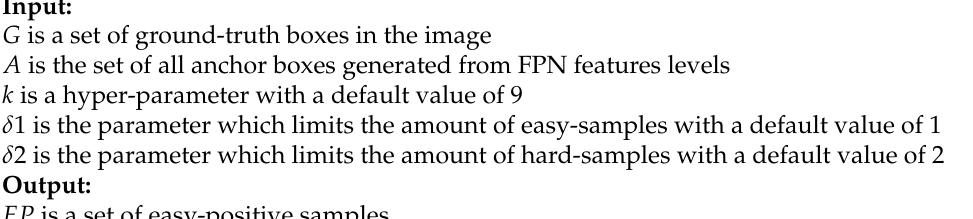
Algorithm 1 Adaptive selection for positive and negative and easy and hard